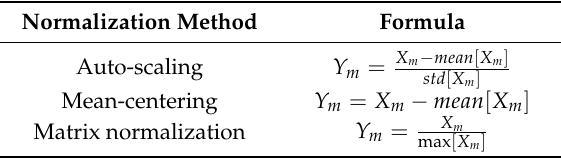
Table 2. Normalization methods.